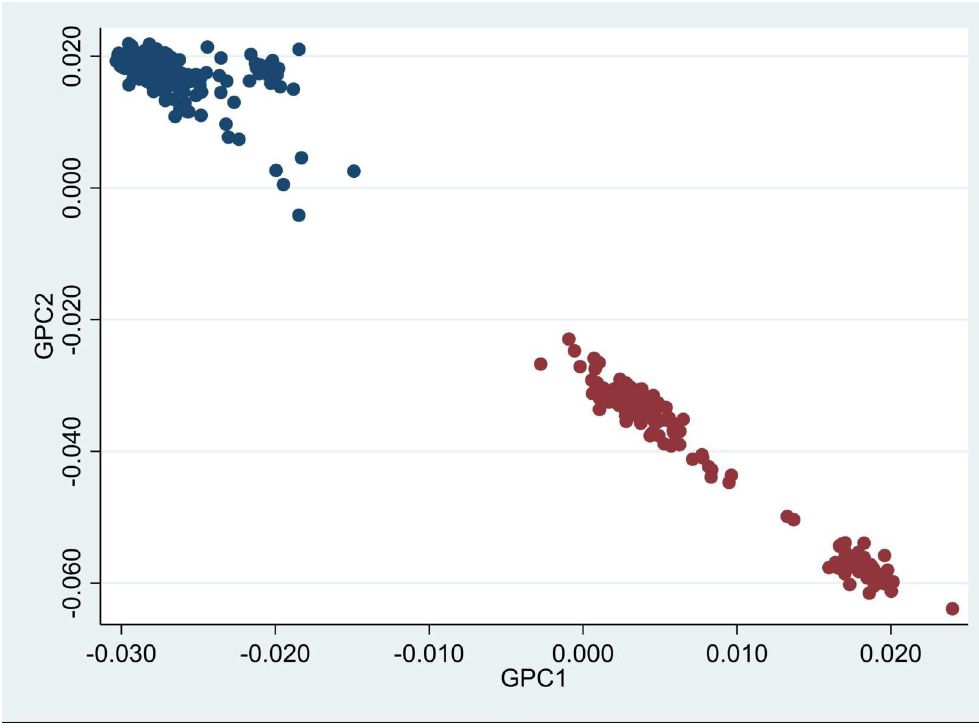
Fig 2. Scatter dot plot of genetic PC1 (GPC1) and PC2 (GPC2) (n = 438). Blue dots are Europeans, red dots are South Asians, based on self-reported ethnicity. It can be noticed that South Asians were separated in two groups, being the upper largest group mainly composed of Pakistanis and the smaller lower group of Sir